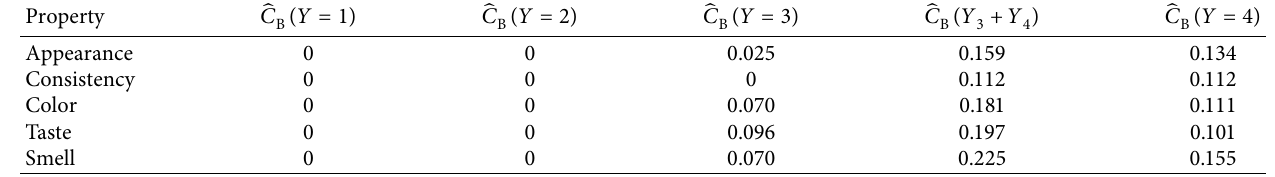
Table 3: Decomposition of the between producers’ variation component according to the response categories.